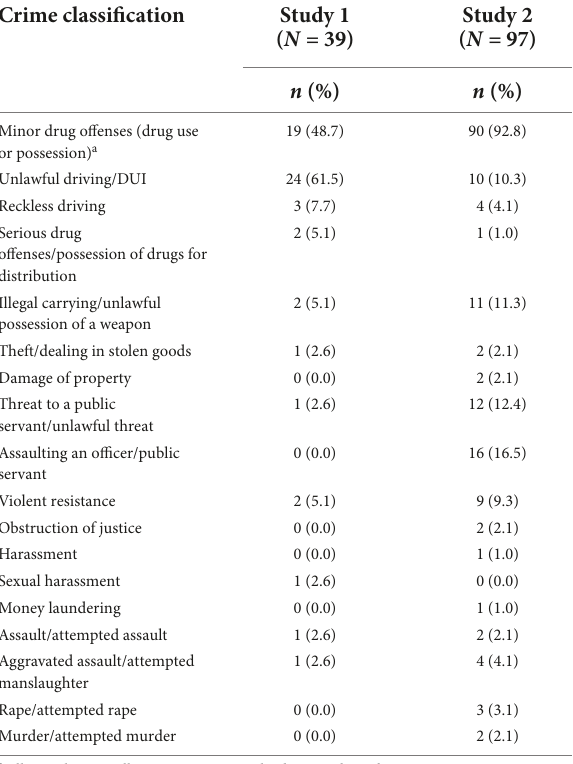
TABLE 1 Distribution of crime classifications within the sample in Study 1 and Study